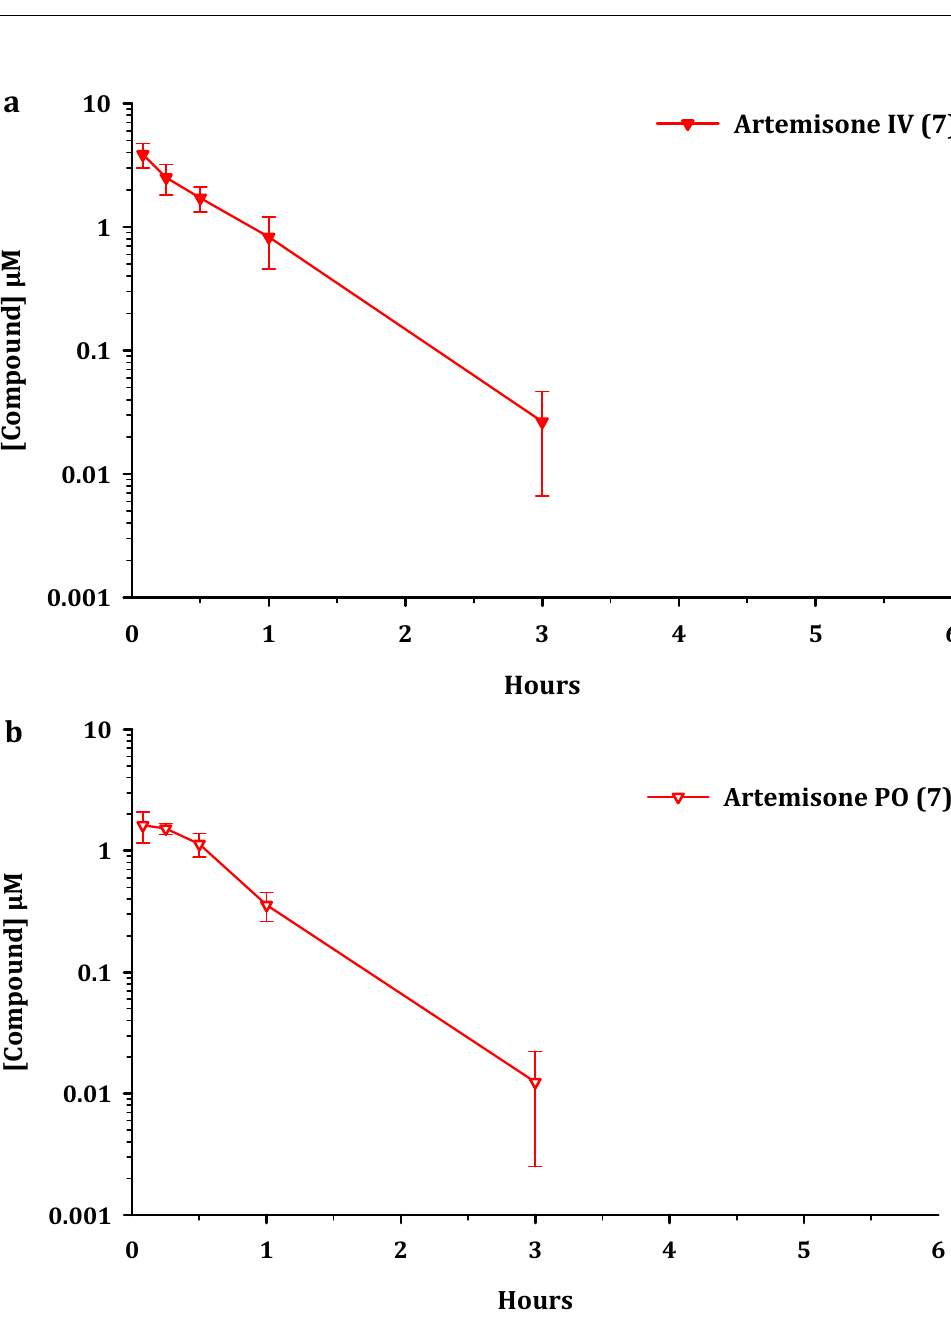
Figure 3. Circulating concentrations of artemisox 6 and its principal metabolite artemisone 7 after ( a ). intravenous ( iv ) administration of artemisox at 5 mg/kg to male C57/BL6 mice ( n = 3) and ( b ). after oral ( po ) administration at 50 mg/kg to male C57/BL6 mice ( n = 3). All results are presented as mean ± standard deviation.